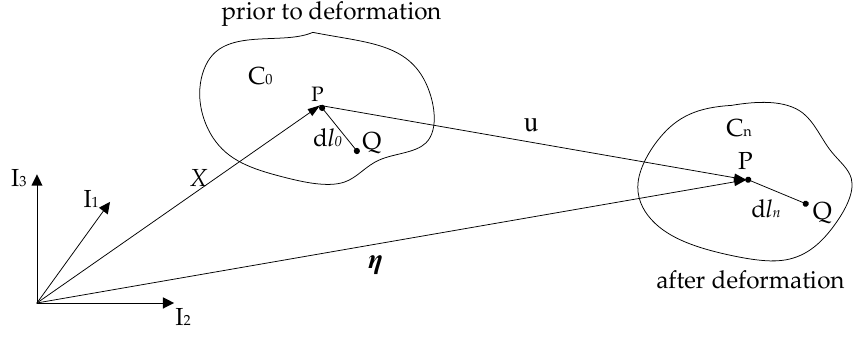
Figure 7. The particle motion during deformation.